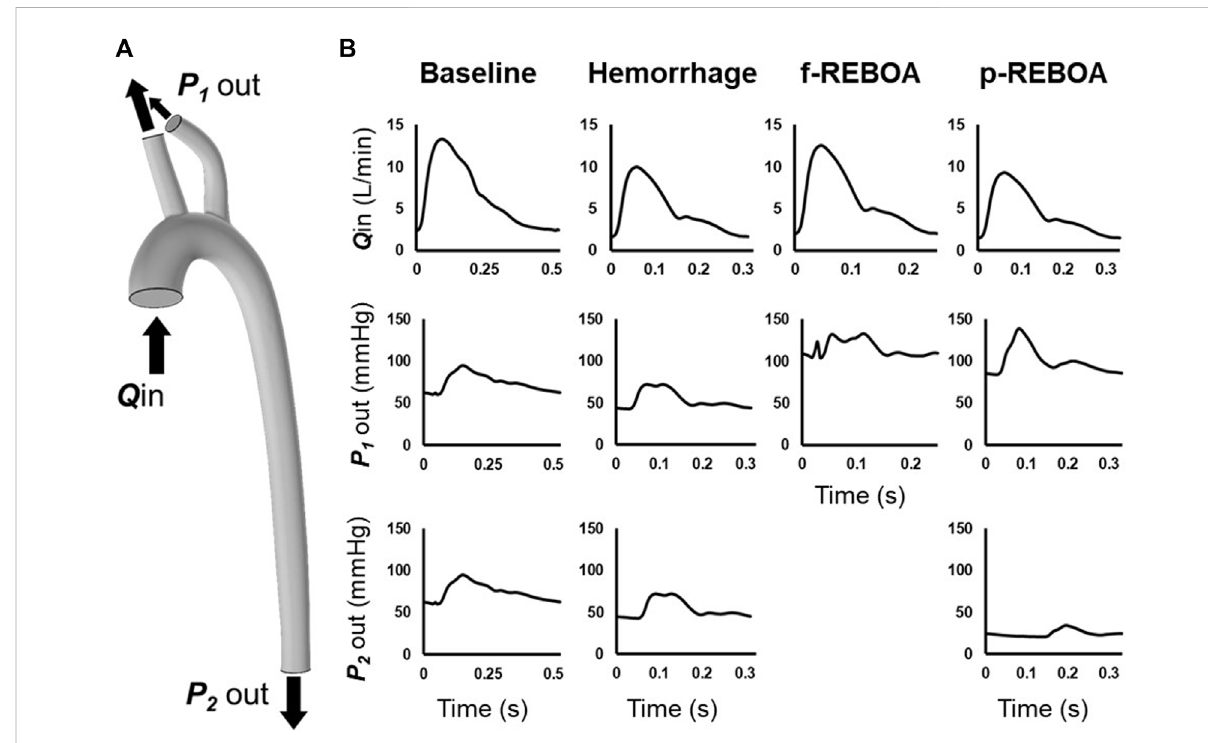
FIGURE 2 Computational model boundary conditions. (A) Location of imposed boundary conditions on 3-D aortic geometry. A fl ow inlet was prescribed at the ascending aorta ( Q in ). Pressure outlets were prescribed to supra-aortic vessels ( P 1 out) and descending thoracic aorta ( P 2 out) (B) In fl ow and outlet pressure waveforms for each model. Flow rate at the ascending aorta Q in was estimated by scaling the in vivo distal fl ow waveform from the distal fl ow probe in the descending aorta to in vivo data output via a Swan Ganz catheter. Supra-aortic pressure outlets, P 1 out, were measured at the left subclavian artery and coupled. P 2 out was iteratively de fi ned to calibrate our model to the available in vivo